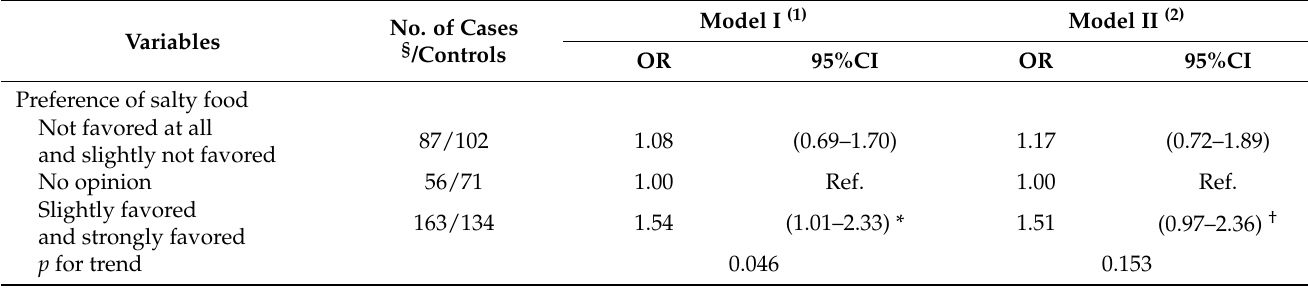
Table 5. Odds ratios of gastric cancer according to preference of salty